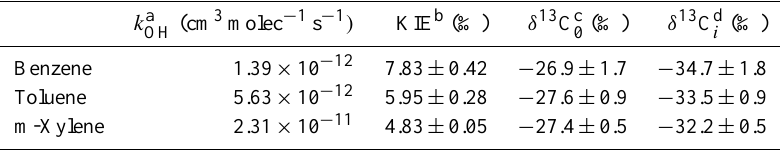
Table 3. Rate constants ( k OH ) , carbon KIE for reactions of aromatic hydrocarbons with OH radicals and isotope ratio of emissions ( δ 13 C 0 ) . Also given are carbon isotope ratios of reaction products formed by the reaction of the unprocessed emissions of precursor VOCs ( δ 13 C i )